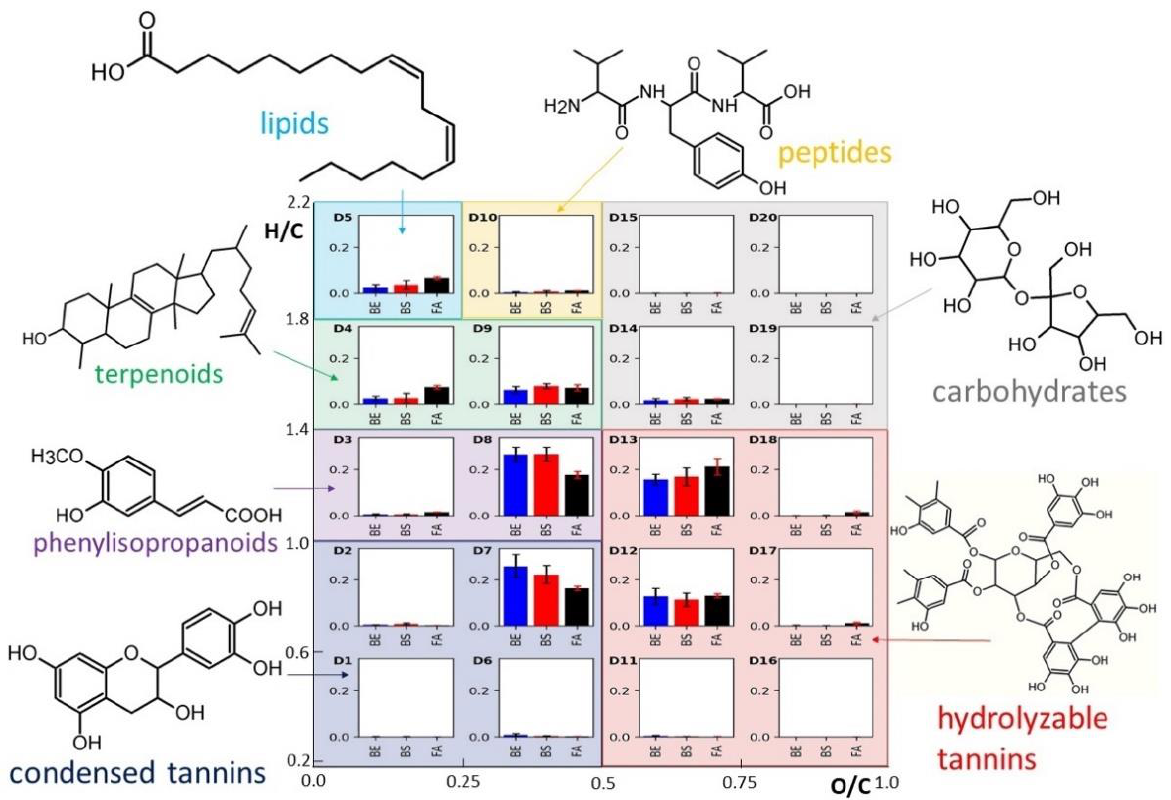
Figure 6. Mean values and standard deviations of the occupational densities of 20 cells in the split Van Krevelen diagram (D 1 –D 20 ) for FA_BE set (the columns are highlighted in blue), for FA_BS set (the columns are highlighted in red), and for the parent FA (the columns are highlighted in black). The plots are arranged in accordance to the cells’ location in the Van Krevelen diagram (1–20). The background colors refer to the seven main chemotypes depicted by the chemical formulae: condensed tannins (gray), phennylisopropanoids (lignins) (lilac), terpenoids (green), lipids (turquoise), peptides (yellow), carbohydrates (light gray), hydrolysable tannins (pink).